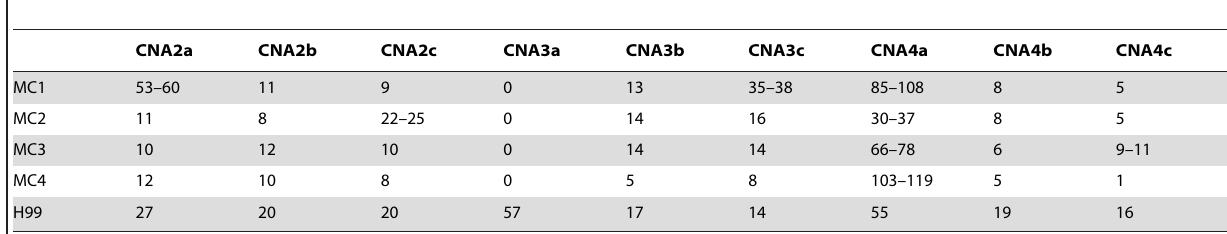
Table 3. Signature profiles of the 4 most prevalent microsatellite complexes and the reference isolate H99 upon whose genome the selection of markers was made.